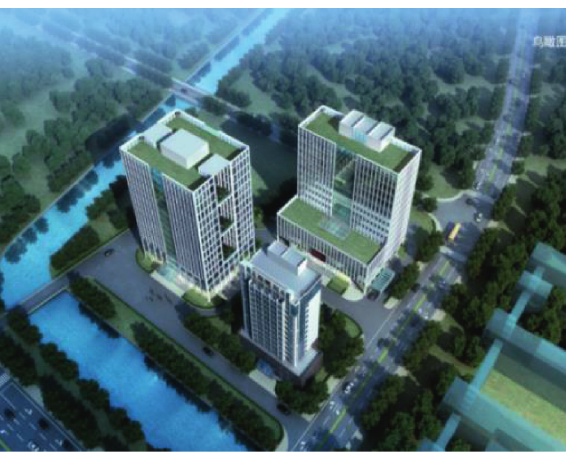
Figure 4: The case study project for the “CJ building.”